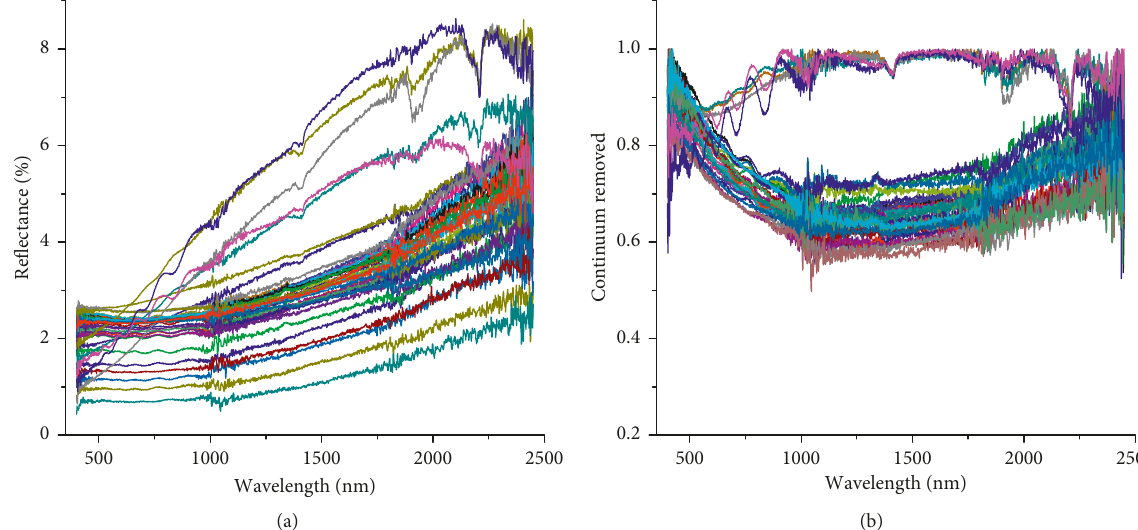
Figure 12: Spectral reflectance curves (a) and continuum-removed spectral curves (b) of 50 nature block samples in the wavelength range of 350–2500nm.